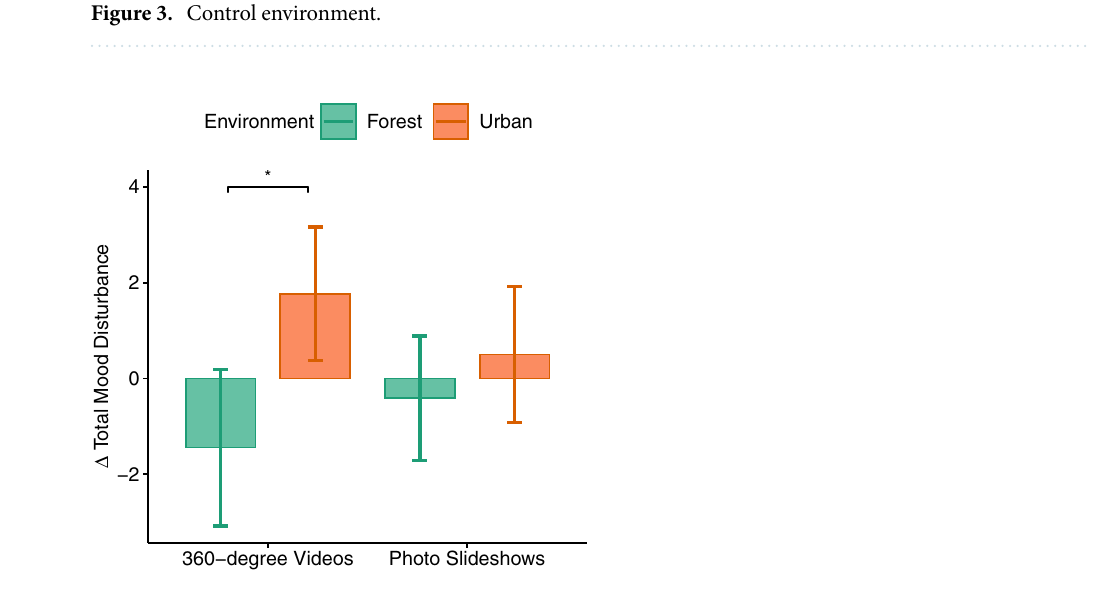
Figure 4. Difference scores of the total mood disturbance.